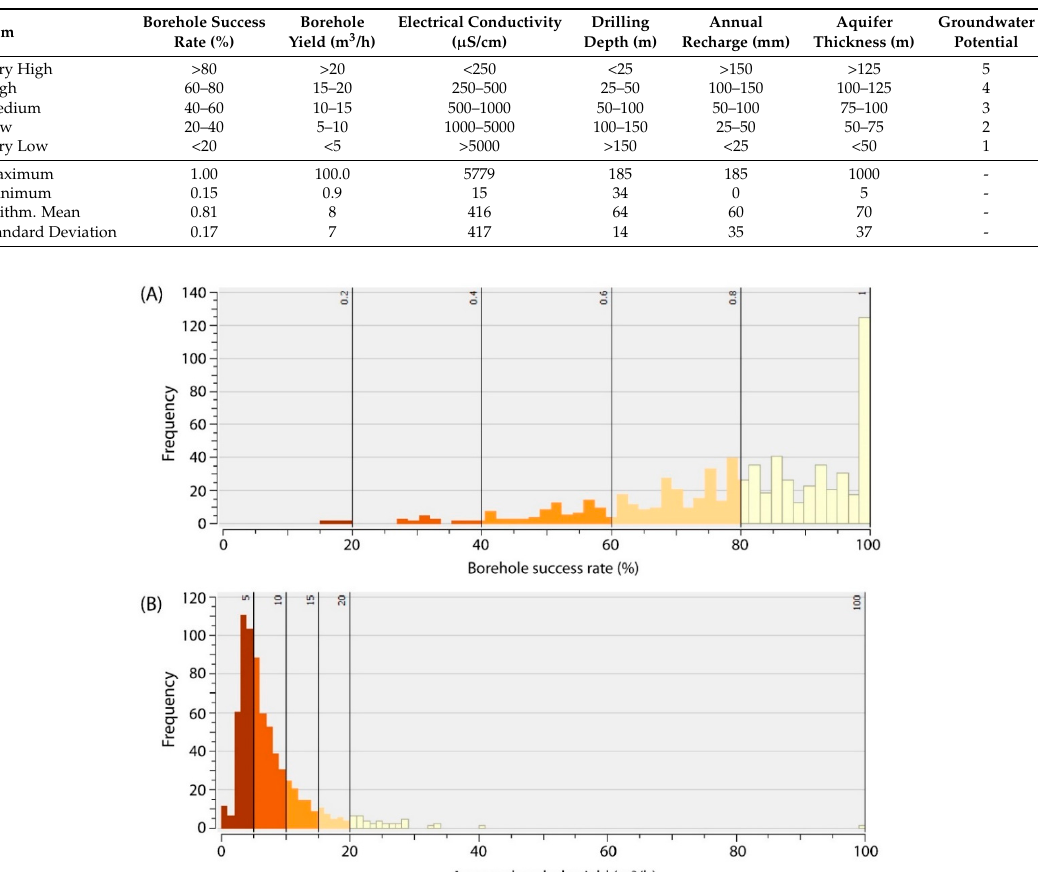
Table 3. Groundwater potential scores for each of the six key variables and basic descriptive statistics of the available data.